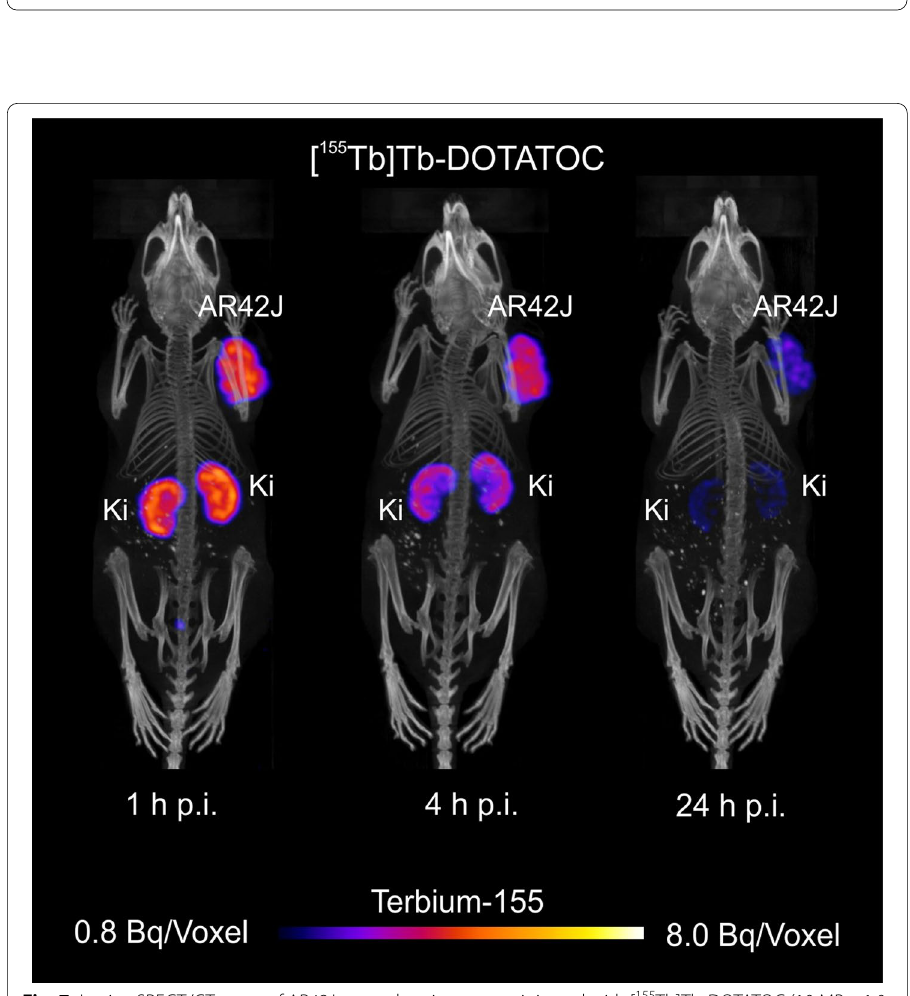
Fig. 7 In vivo SPECT/CT scans of AR42J tumor-bearing mouse injected with [ 155 Tb]Tb-DOTATOC (10 MBq, 1.0 nmol; 100 μL). The scans were acquired 1, 4 and 24 h pi. During the scans the mouse was anesthetized with a mixture of isoflurane and oxygen. (AR42J SSTR-positive tumor xenograft, Ki kidney). (Voxel size: 0.3 = =